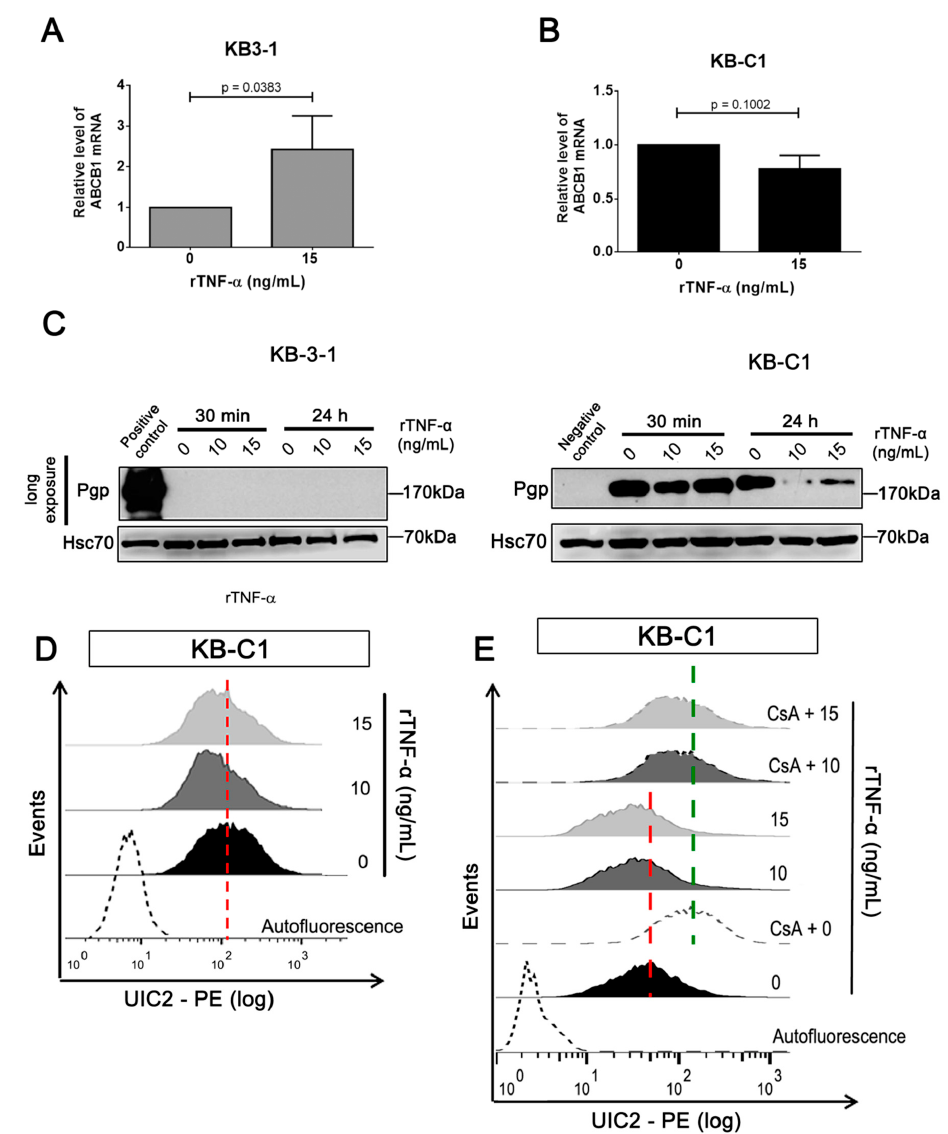
Figure 3. P-glycoprotein (Pgp) expression levels analysis in parental and MDR cell lines after recombinant TNF- α treatment. ABCB1 mRNA levels determined by qRT-PCR after 24 h of 15 ng / mL rTNF- α treatment in ( A ) KB-31 and ( B ) KB-C1 cells. ( C ) Immunoblot analysis of Pgp protein levels after 30 min or 24 h of 10 or 15 ng / mL rTNF- α treatment. Pgp protein levels expression determined by ( D ) specific antibody staining and ( E ) shift-assay after 24 h of 10 or 15 ng / mL rTNF- α treatment in KB-C1 cells, using flow cytometry. Cyclosporine A (CsA) means treatment with 20 µ M of cyclosporine A. ( C ) KB-3-1 and KB-C1 cell lines were used as negative and positive controls, respectively. ( D ) Empty histogram represents cellular autofluorescence of KB-C1 cells ; black histogram represents non-treated cells ; dark gray and light gray histograms represent treatment with 10 or 15 ng / mL rTNF- α , respectively. ( E ) Empty black histogram represents cellular autofluorescence; black histogram represents non-treated cells; empty gray histogram represents treatment with CsA ; dark gray and light gray histograms represent treatment with 10 or 15 ng / mL rTNF- α , respectively. Dark gray dashed and light gray dashed histograms represent co-treatment with CsA plus 10 or 15 ng / mL rTNF- α , respectively. Data are means ± SD of three independent experiments. t -test was used to analyze the qRT-PCR results. * p < 0.05 indicates the statistical significance of data compared to non-treated